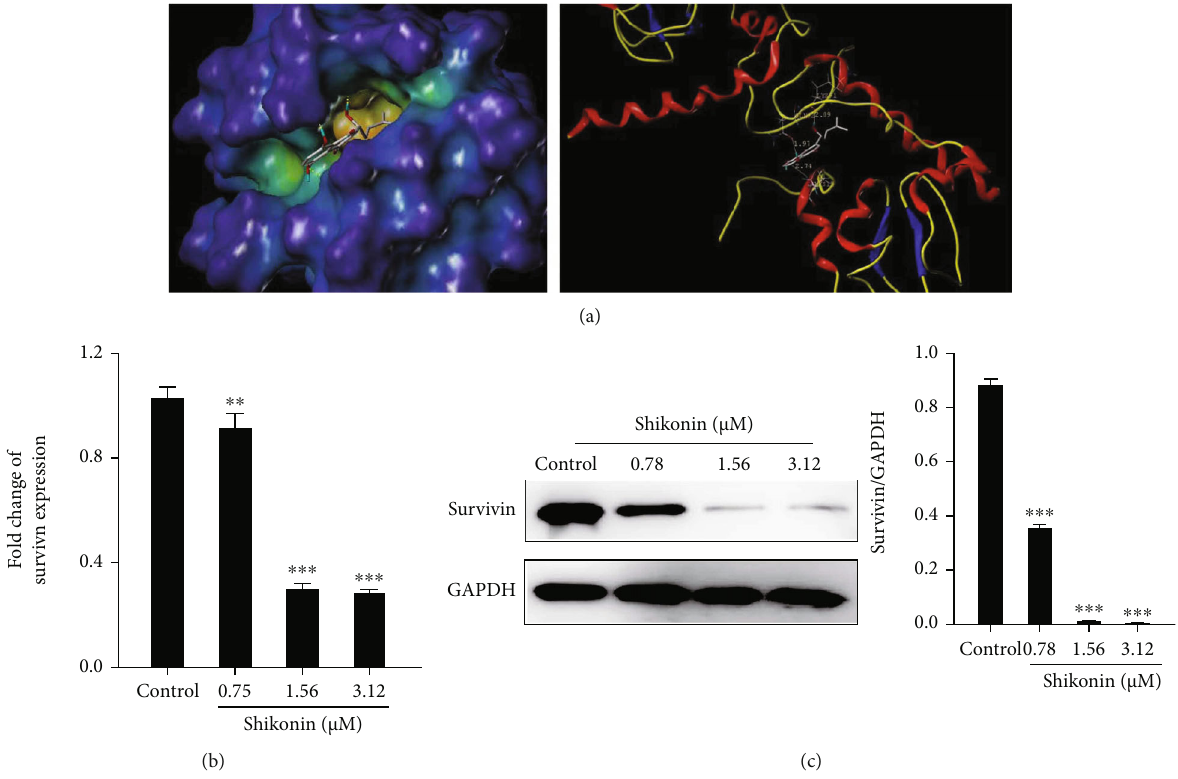
Figure 4: E ff ect of shikonin on survivin. (a) Docked molecule (shikonin) in the crystal structure of survivin (PDB ID: 1XOX). Hydrogen bonds were depicted as dashed yellow lines. (b) The mRNA level of survivin in H1299 cells treated with shikonin (0, 0.78, 1.56, and 3.12 μ M) for 48h. (c) The protein level of survivin in H1299 cells treated with shikonin (0, 0.78, 1.56, and 3.12 μ M) for 48 h was examined by western blot assay. Data are presented as the mean ± standarderror of the mean ( n = 3 ). ∗∗ P < 0 : 01 and ∗∗∗ P < 0 : 001 vs.